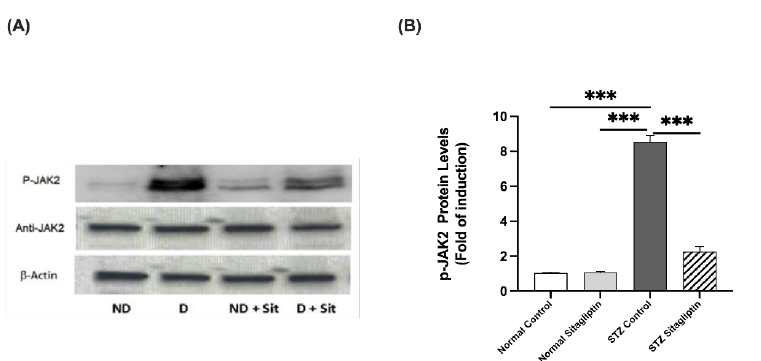
Figure 4. Effects of sitagliptin on phosphorylated Janus kinase (P-JAK2) expression in STZ-induced diabetic rats. ( A ) Representative images of P-JAK2 in kidney tissue homogenates; ND, normal control group; D, STZ-induced diabetic control group; ND + Sit, normal control group treated with sitagliptin; D + Sit, sitagliptin-treated diabetic group. Resolution of the proteins obtained from sample tissues was performed with SDS-PAGE, and then the P-JAK antibody was used for immunoblotting, as well as total JAK2 and β -actin antibodies subsequent to stripping. ( B ) Quantitative outcomes of immunoblotting technique utilizing ImageJ software. B-Actin was used for the normalization of the levels of P-JAK2 protein. The expression of quantities is in the form of fold induction relative to the group comprising normal controls. The data denote the mean ± SEM ( n = 6 samples from 6 rats